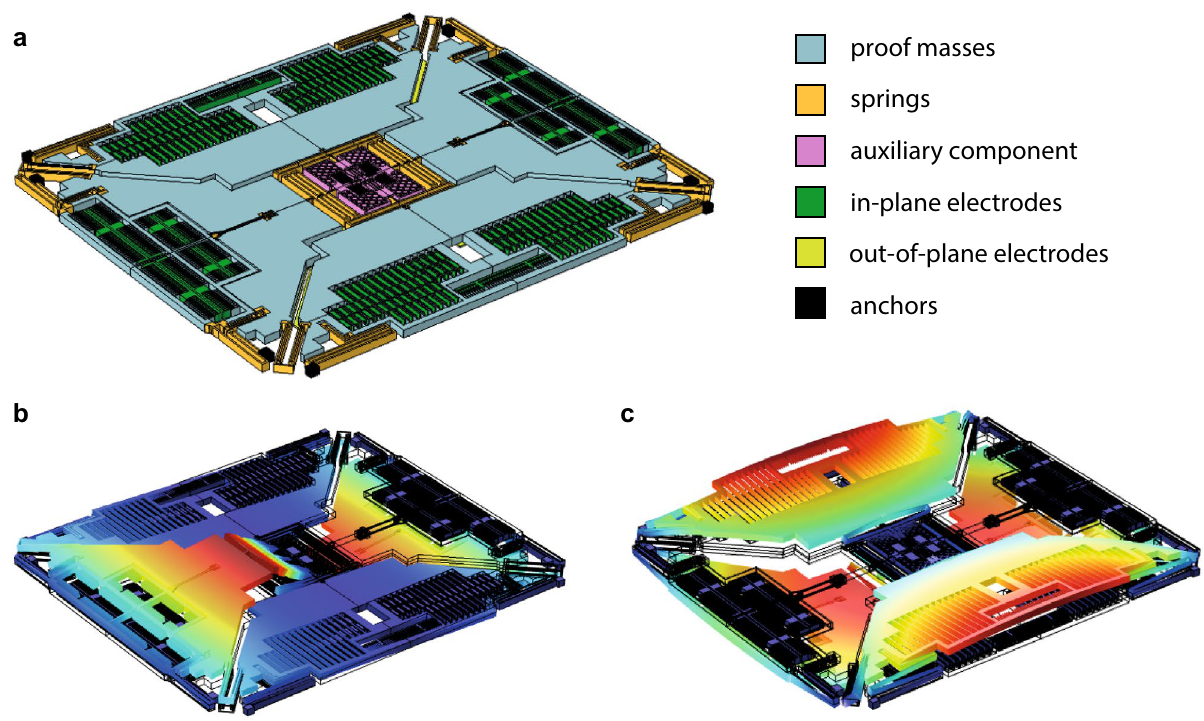
Figure 1. ( a ) Schematic view of the MEMS gyroscope test-structure. ( b ) Roll ( f 1 = 22,522 Hz) and ( c ) spurious roll ( f 2 = 43,386 Hz) modes. The contour plot of the displacement field is shown in